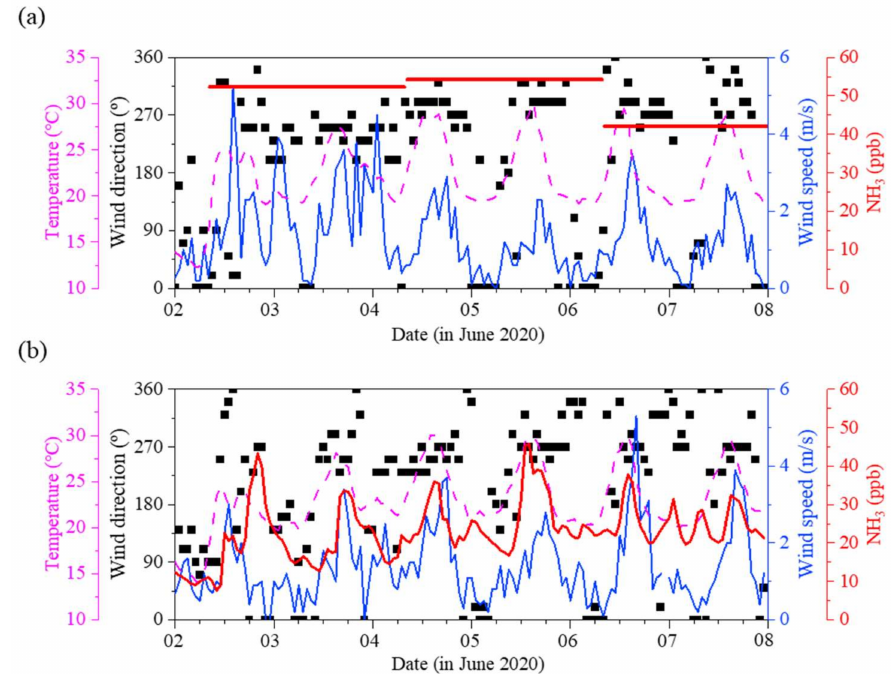
Figure 5. Events of high atmospheric NH 3 concentrations for the ( a ) rural average at sites R2 and R3 (Jeongeup) measured by passive samplers and ( b ) urban (Jeonju) area measured by CRDS from 2–8 June 2020. Temperature (pink-dashed lines), wind direction (black dots), wind speed (blue lines), and NH 3 concentrations (red lines) are included.